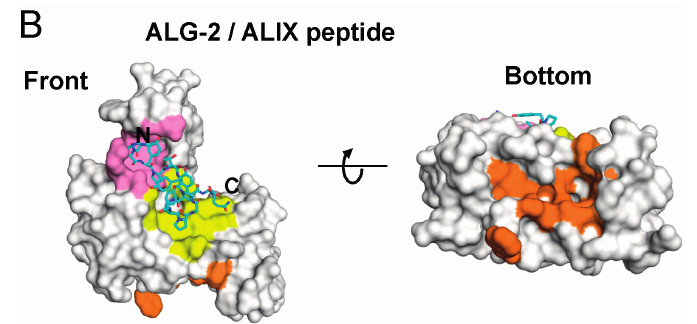
Figure 4. Different hydrophobic pockets used for binding to Sec31A and ALIX. While the Sec31A peptide ( A , shown in the stick model; carbons colored in green) binds to Pocket 3 (orange), the ALIX peptide ( B , shown in the stick model; carbons colored in cyan) binds to adjacent Pocket 1 ( B , pink) and Pocket 2 ( B , yellow). Unrelated areas are shown by gray surfaces. ( A ) Complex between ALG-2 and the Sec31A peptide (PDB code: 3WXA; chains A and C); ( B ) complex between ALG-2 and the ALIX peptide (PDB code: 2ZNE; chains A and C).